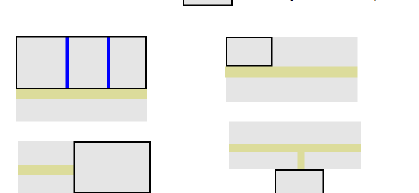
Figure 15. Four kinds of deployment manners of academic spaces